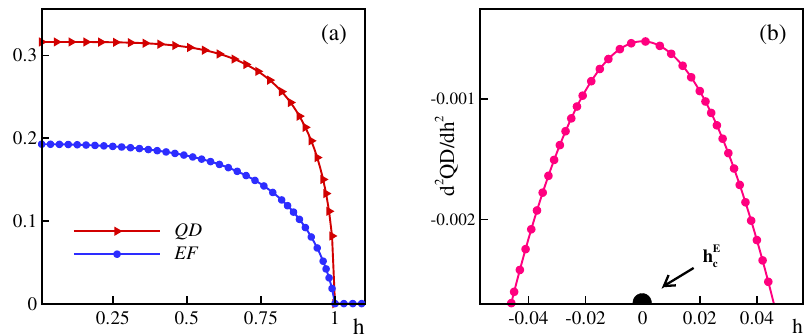
Figure 1. ( a ) Magnetic field dependence of QD and EF; and ( b ) second derivative of the QD in the vicinity of h E c for the NN pair of spins at zero